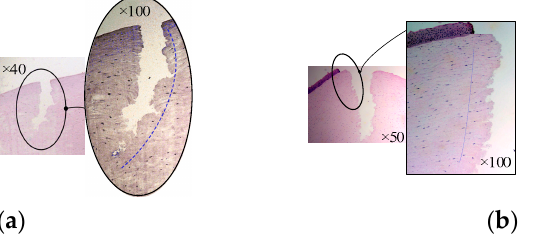
Figure 17. Microscopic images of corneal sections. ( a ) The cornea is cut by manual trephine. ( b ) The cornea is cut by the ultrasound-assisted end effector.